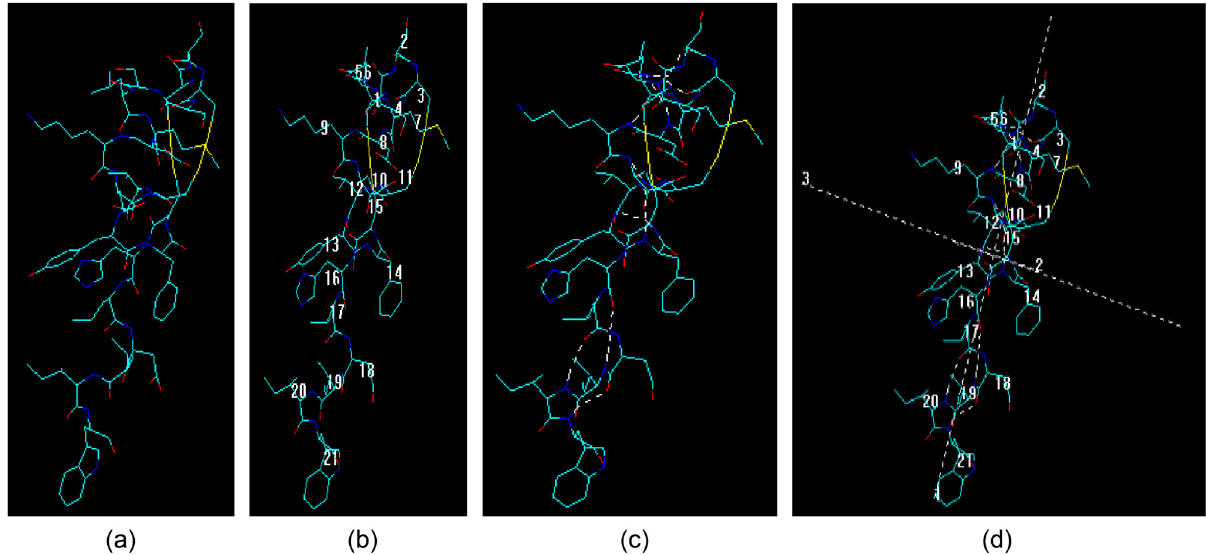
Figure 7: ET - I model without explicit hydrogens and S – S bonds; ( a ) ET - I model, MEC; ( b ) AA residues identi fi ed after cyclization between AA Cys – Cys 1 – 15 and Cys – Cys 3 – 11; ( c ) facilitated hydrogen - bondings between residues, shown as broken white lines; ( d ) atoms and residues distribution weightage shown along the dotted lines on the internal axes from 1 – 2 and 3 – 4 of other than hydrogen - bondings broken lines of the residues ( for hydrogen - bondings refer to model c ) .